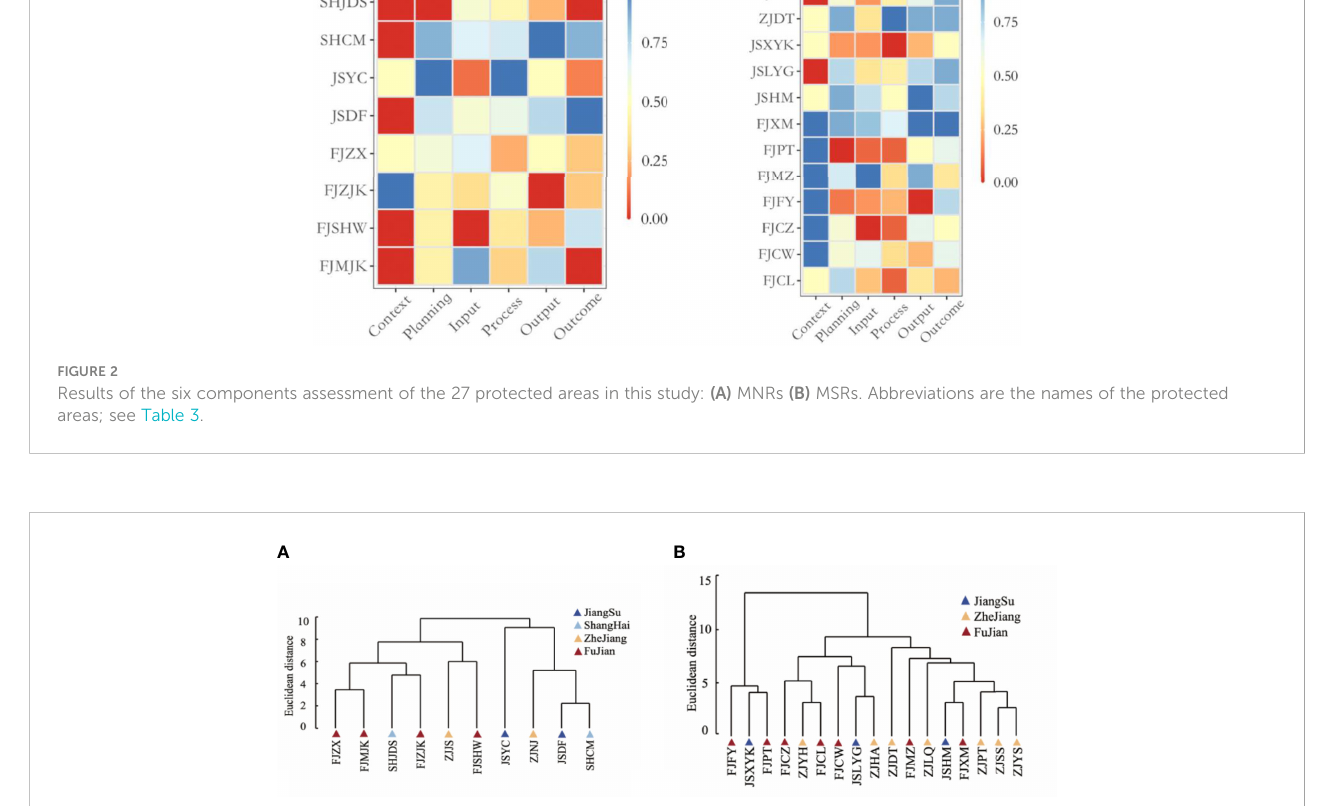
FIGURE 3 Clustering Analysis of Differences in Management Effectiveness of Protected Areas in the East China Sea Based on the Bray-Curtis Distance Algorithm: (A) MNRs (B) MSRs. Abbreviations are the names of the protected areas; see Table